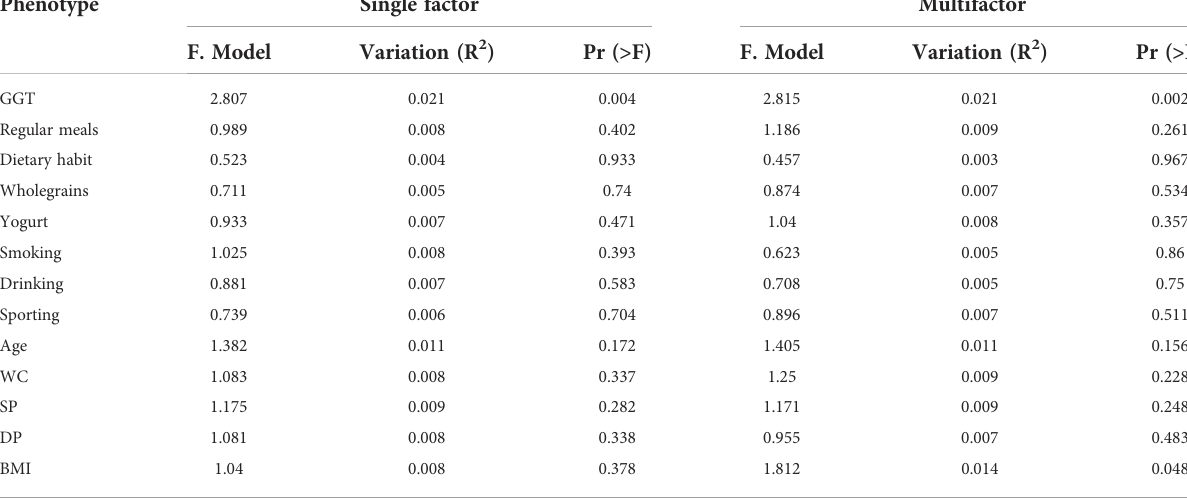
TABLE 2 The in fl uence of the basic attributes of the participants on the gut microbiome in the species level.